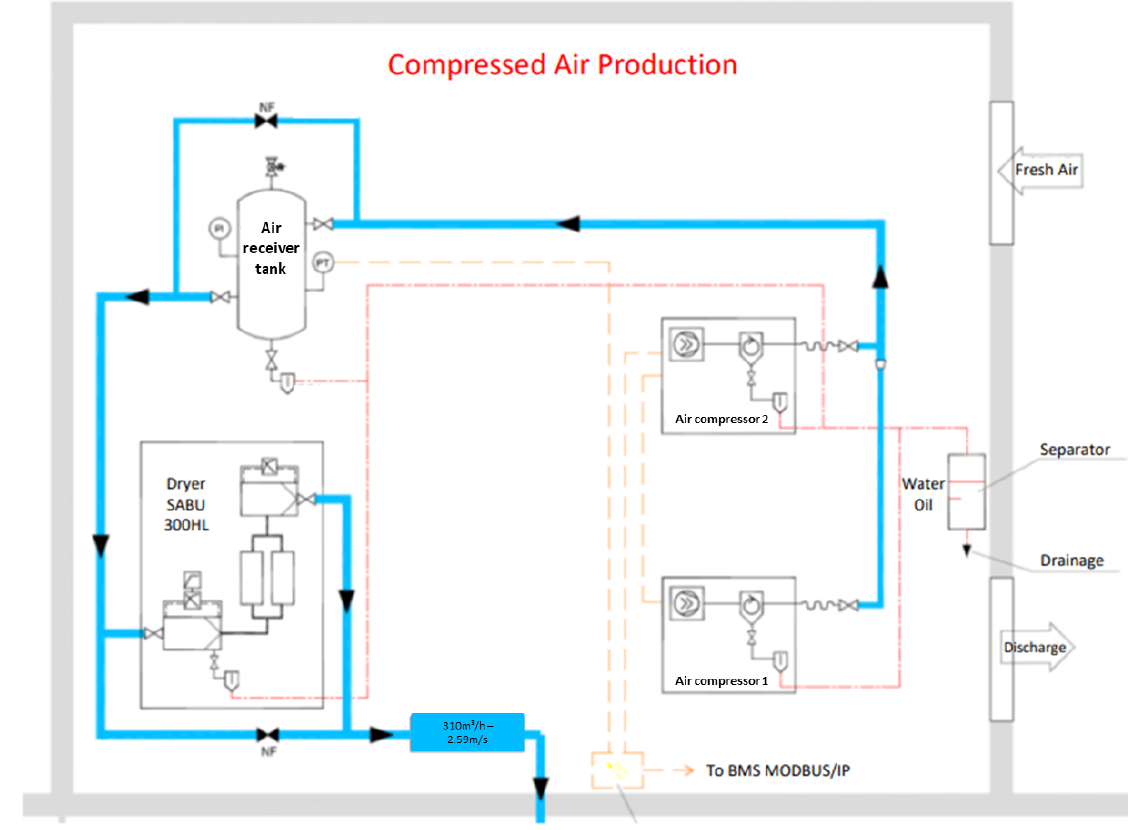
Figure 4. Compressed air production scheme.